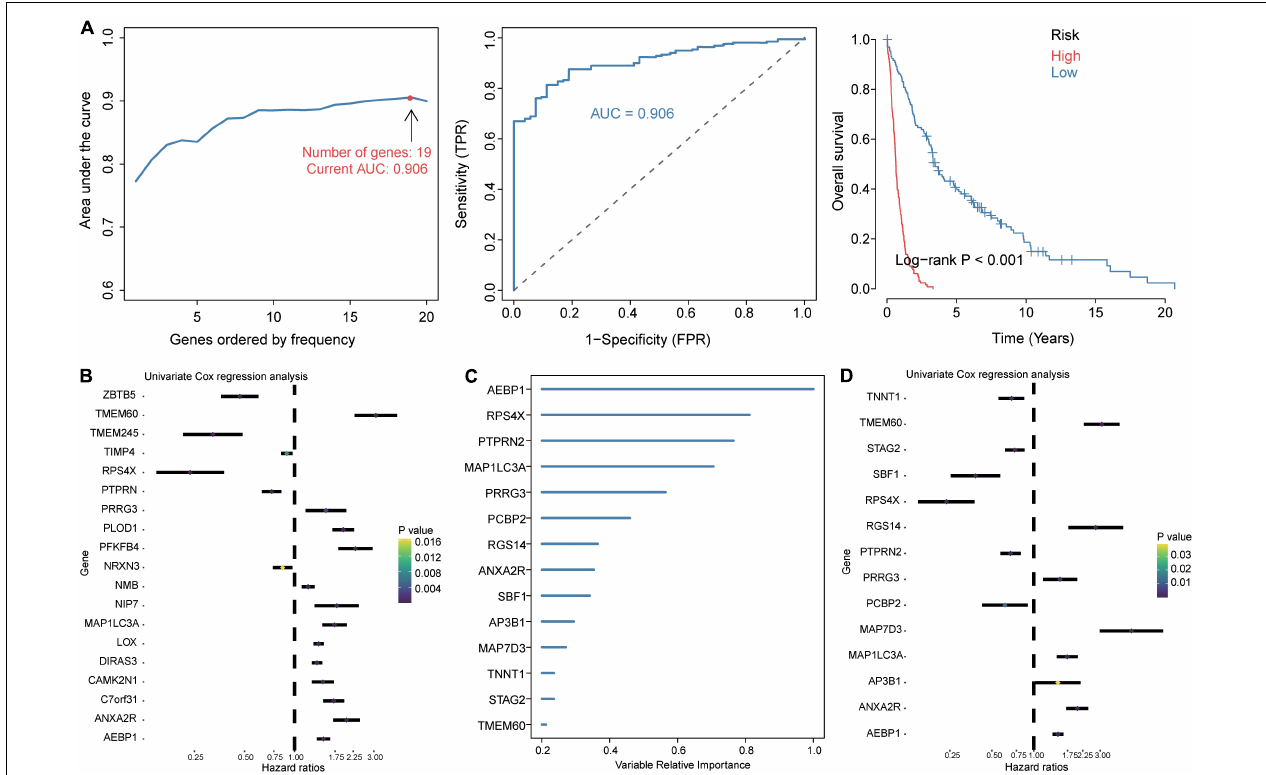
FIGURE 3 | Identification of prognosis-related candidate genes in GBM. (A) The 19 gene signatures with the largest AUC values for diagnosing GBM. Signatures were identified using the least absolute shrinkage and selection operator (LASSO) algorithm, receiver operating characteristic curves, and Kaplan–Meier analysis of low- and high-risk groups. AUC, area under the receiver operating characteristic curve; FPR, false positive rate; TPR, true positive rate. (B) Forest plots of Cox regression analysis of gene signatures in the LASSO model. (C) Importance ranking of 15 gene signatures based on random forest survival modeling. (D) Forest plots of Cox regression analysis of gene signatures in the random forest survival